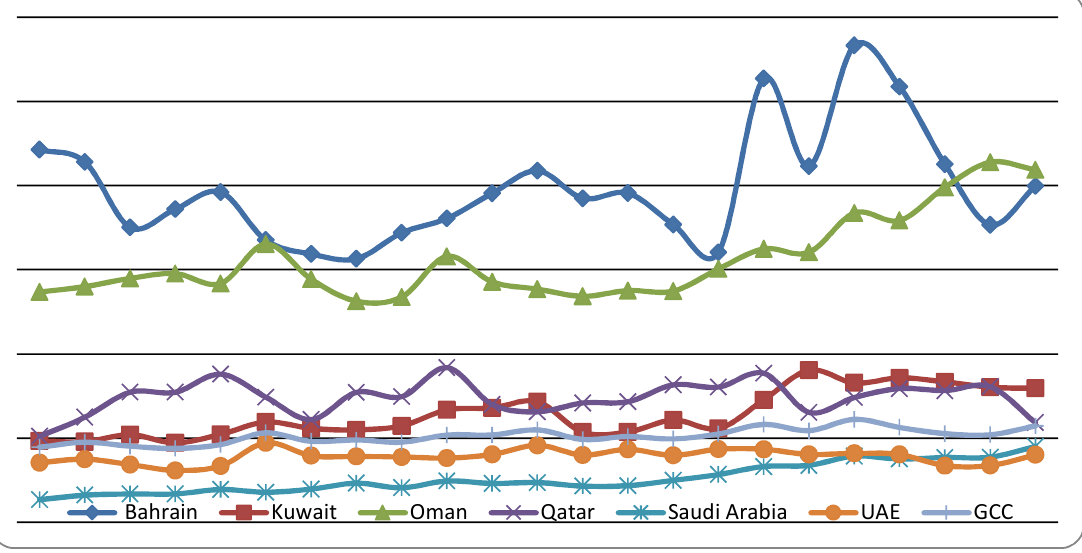
Fig. 2. Relative importance of the intra trade of the GCC member to rest of